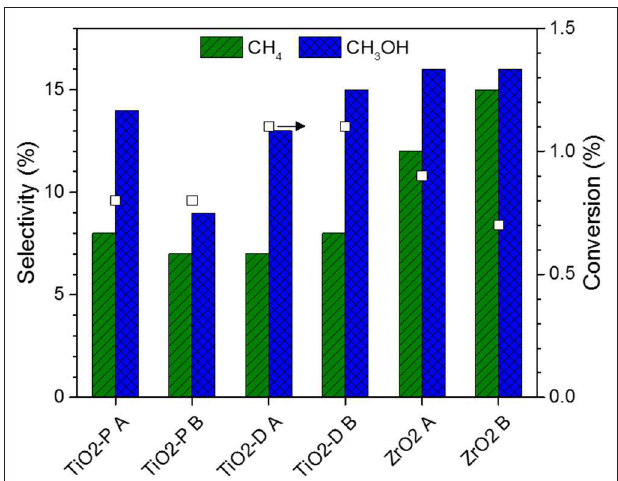
FIGURE 8 | Conversion and selectivity for supported Mo nitride catalysts. Catalytic conditions: 400mg of catalyst, 50ml min − 1 , 250 ◦ C, 30 bar, H 2 :CO 2 = 3:1, 150min on stream after stabilization of the